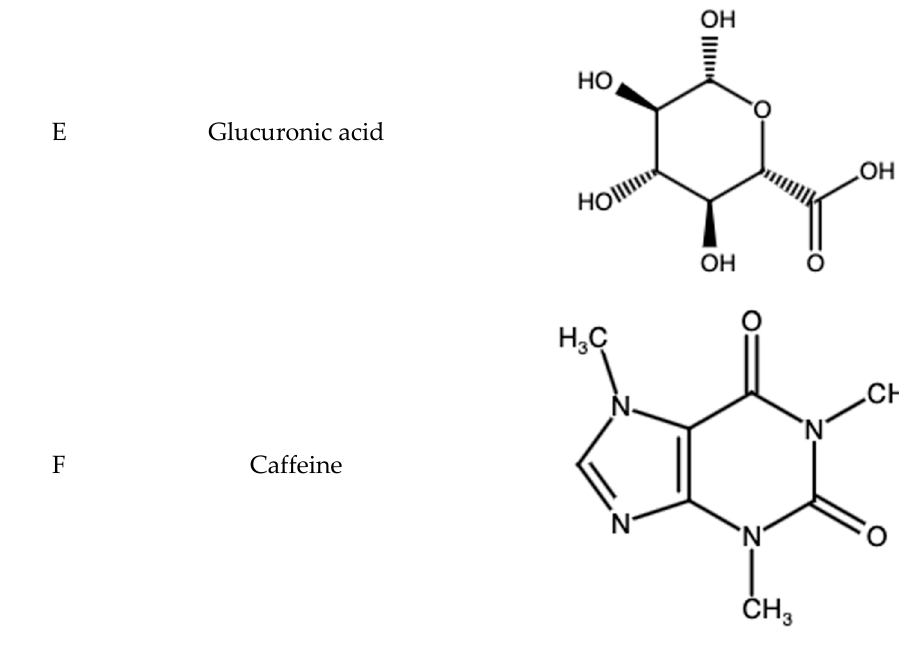
Figure 1. Several chemical structures for example compounds found in kombucha including: ( A ) vitamin C, ( B ) β -catechin, ( C ) ethanol, ( D ) lactic acid, ( E ) glucuronic acid, and ( F ) caffeine.